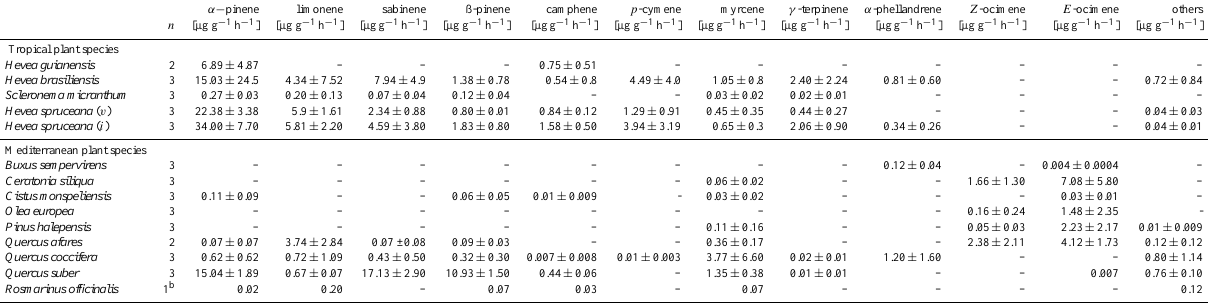
Table 5. Monoterpene species emitted a from Mediterranean and tropical plant species measured with GC-FID. All averages ± standard errors are calculated from < 100 samples (tropical) or 18–83 samples (Mediterranean) from n tree individuals. Others include in P. halepensis (terpinene-4-ol), in Q. afares (linalool and allo-ocimene), in Q. coccifera ( α -thujene, ß-phellandrene, eucalyptol and α -terpinene), in Q. suber ( α -thujene, menthol, terpinolene, o -cymene, terpinene-4-ol, cis-sabinene hydrate, borneol and α -terpinene), in R. officinalis (eucalyptol and camphor) in H. spruceana (i) (3-carene), in H. spruceana (v) (3-carene).